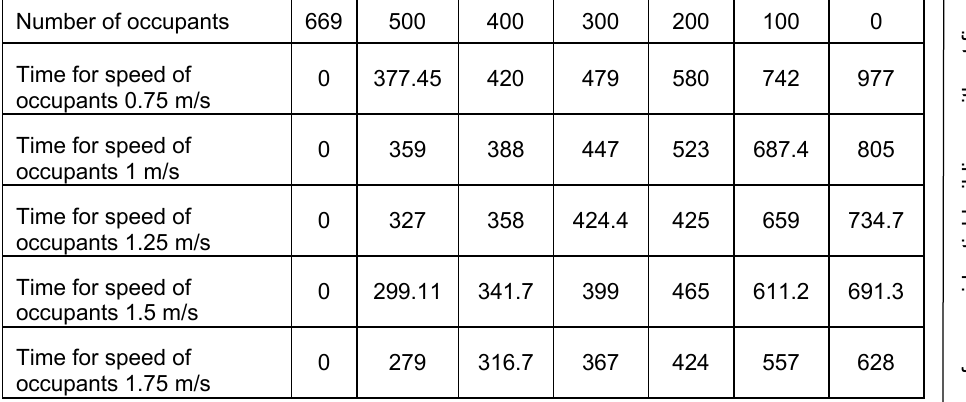
Table 19 – Simulation results in seconds for the third scenario, with elevators disabled and the first and the fourth entrances/exits blocked and for the occupants’ speeds